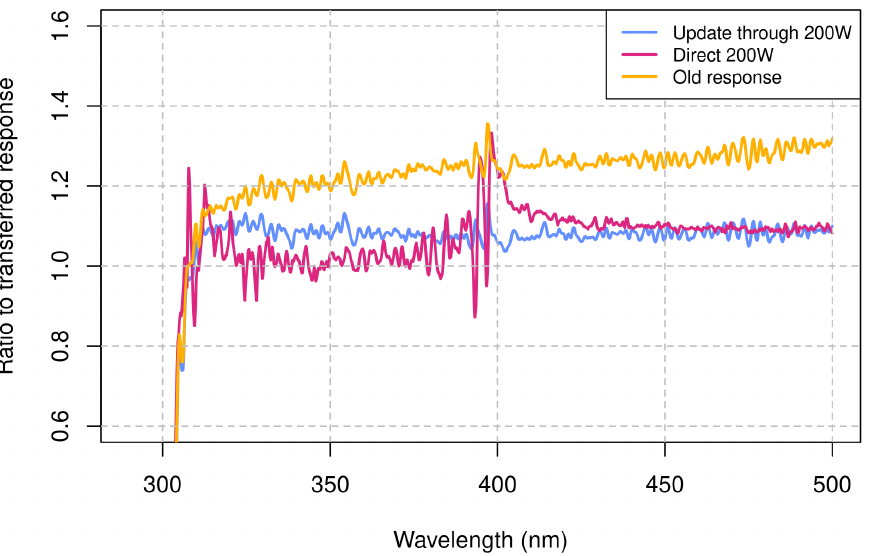
Figure 9. Ratio between the AvaSpec response determined in three different ways with respect to the reference response (transferred from the Bentham in P3): response calculated in P1 (yellow, “old response”); response determined directly from the 200 W lamp (pink line); response transferred from Bentham in P1, further updated based on changes of the lamp measurements between P1 and P3 (blue